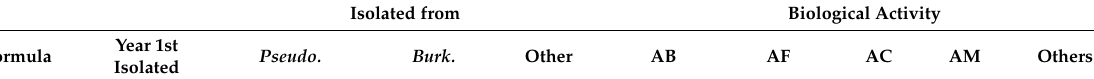
Isolated from Biological Isolated from Isolated Activity